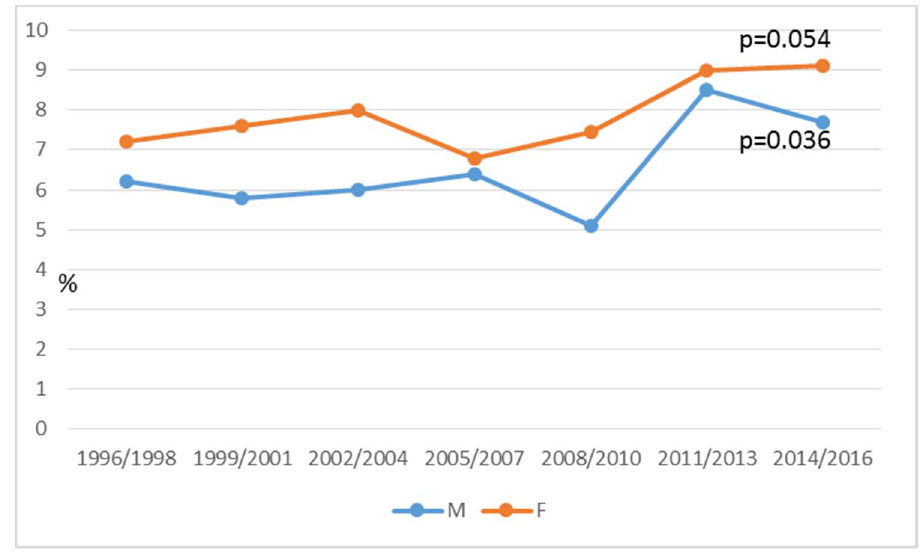
Figure 2. Prevalence of fragrance mix-1 sensitization from 1996 to 2016 in both sexes.